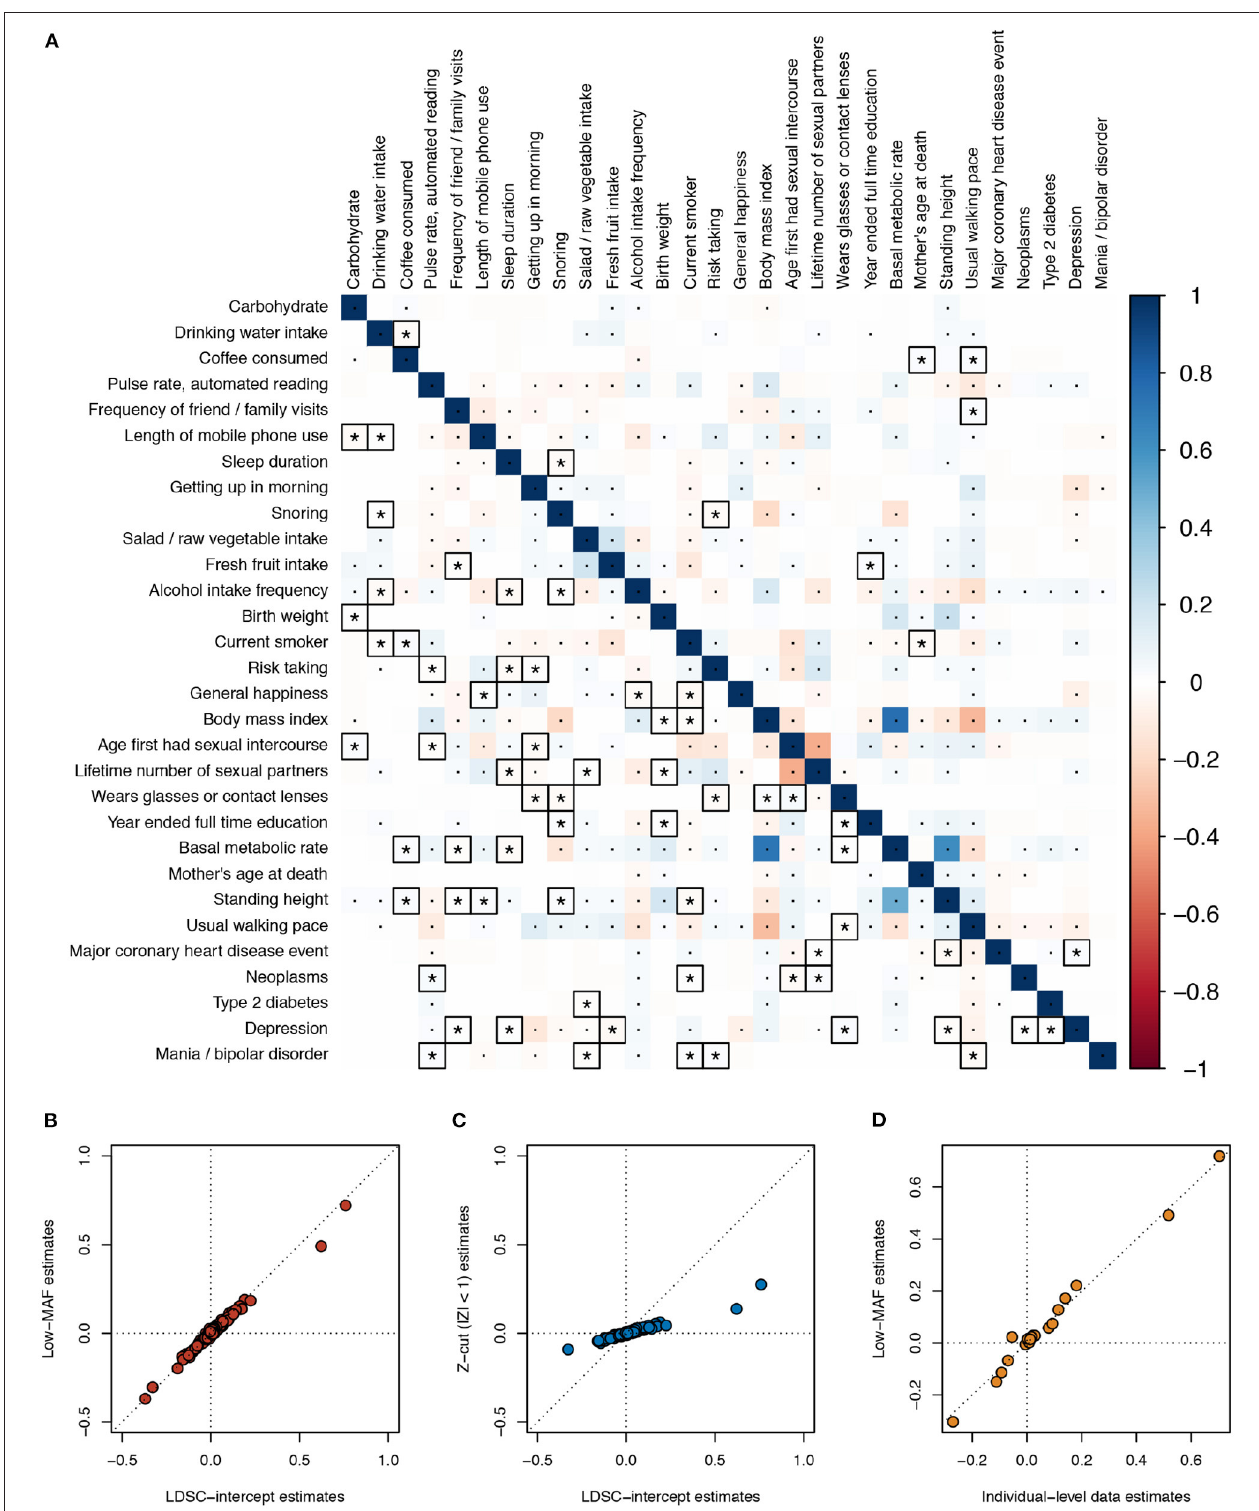
FIGURE 3 | Phenotypic correlation estimates across 30 UK Biobank traits. (A) Estimates using the low minor allele frequency (MAF) estimator (lower triangle) and LD score regression (LDSC) intercept (upper triangle) are compared. The low MAF estimates were based on 70,042 single nucleotide polymorphisms (SNPs) with